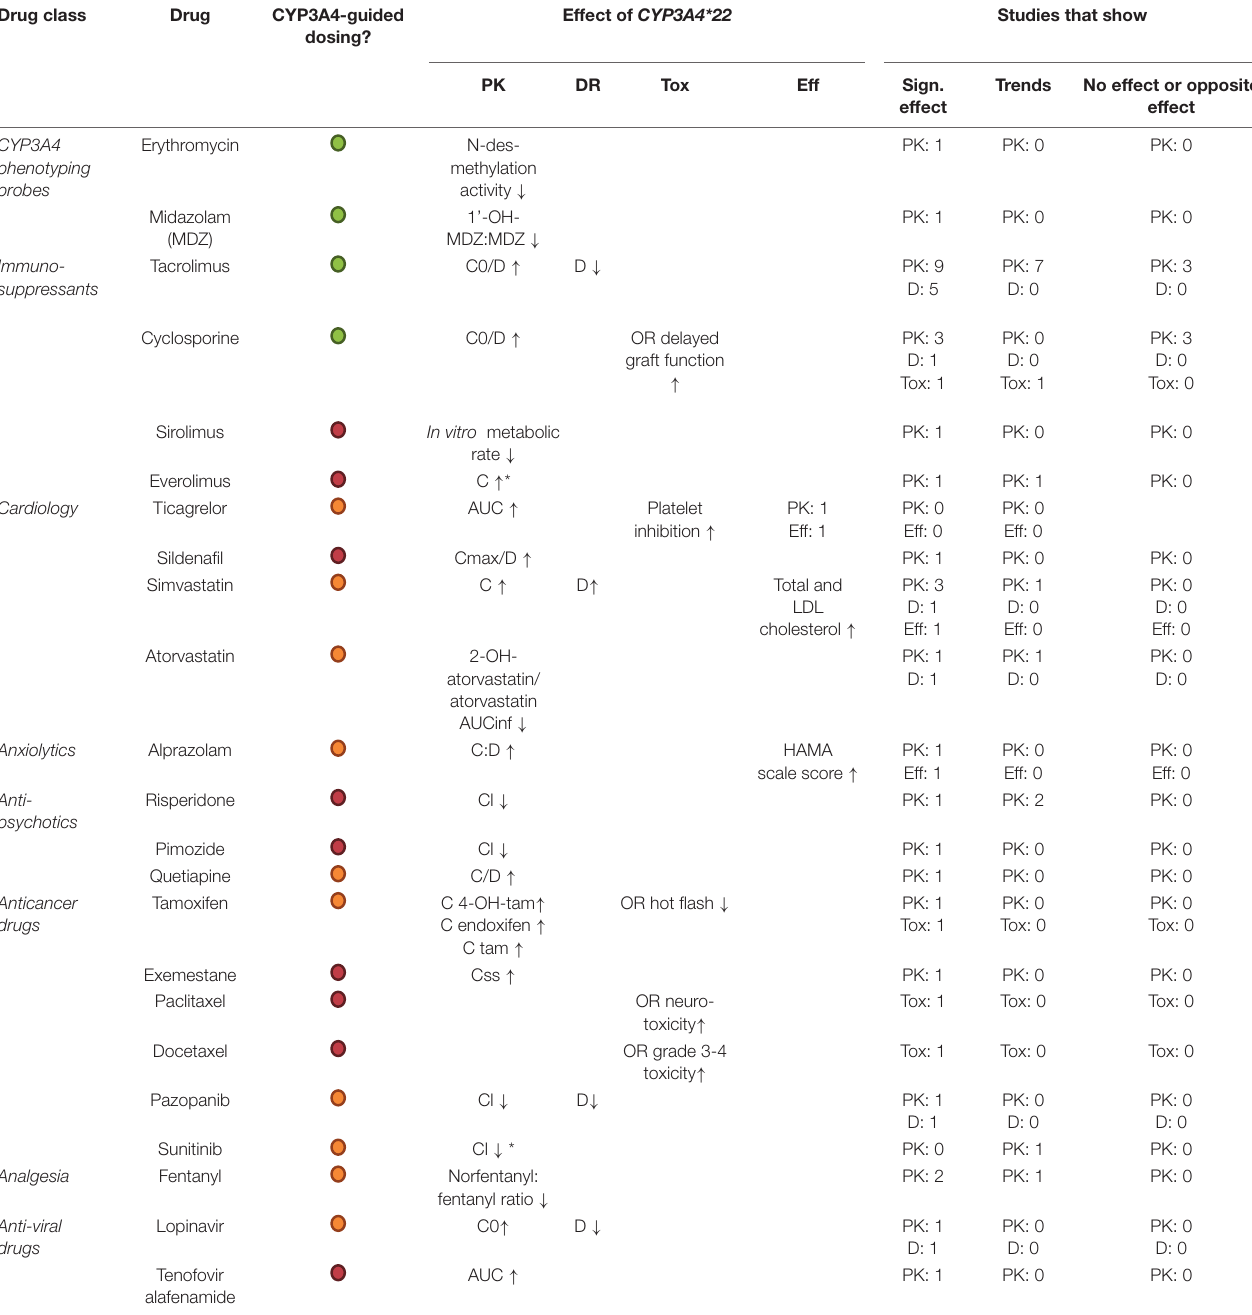
TABLE 1 | Summary of effect of CYP3A4*22 on pharmacokinetics (PK), dose requirement (DR), toxicity (Tox) or effect (Eff) of the described